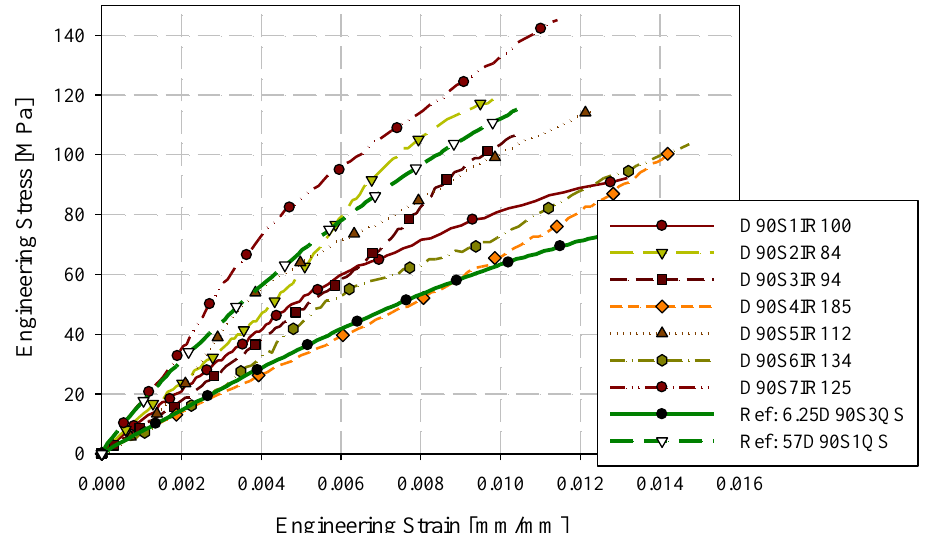
Figure 10. 90-degree intermediate strain rate engineering stress-strain responses with upper and lower bound quasi-static reference responses.